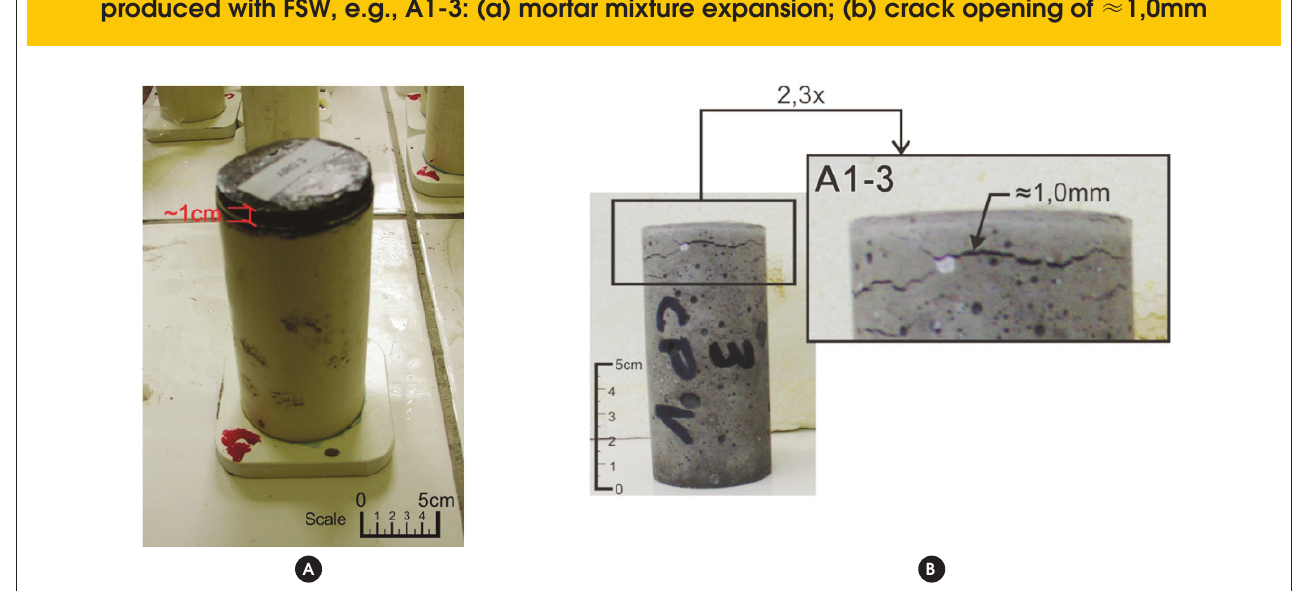
Figure 2 – Visual observation of the expansive reactions that have occurred in the mortars produced with FSW, e.g., A1-3: (a) mortar mixture expansion; (b) crack opening of ≈